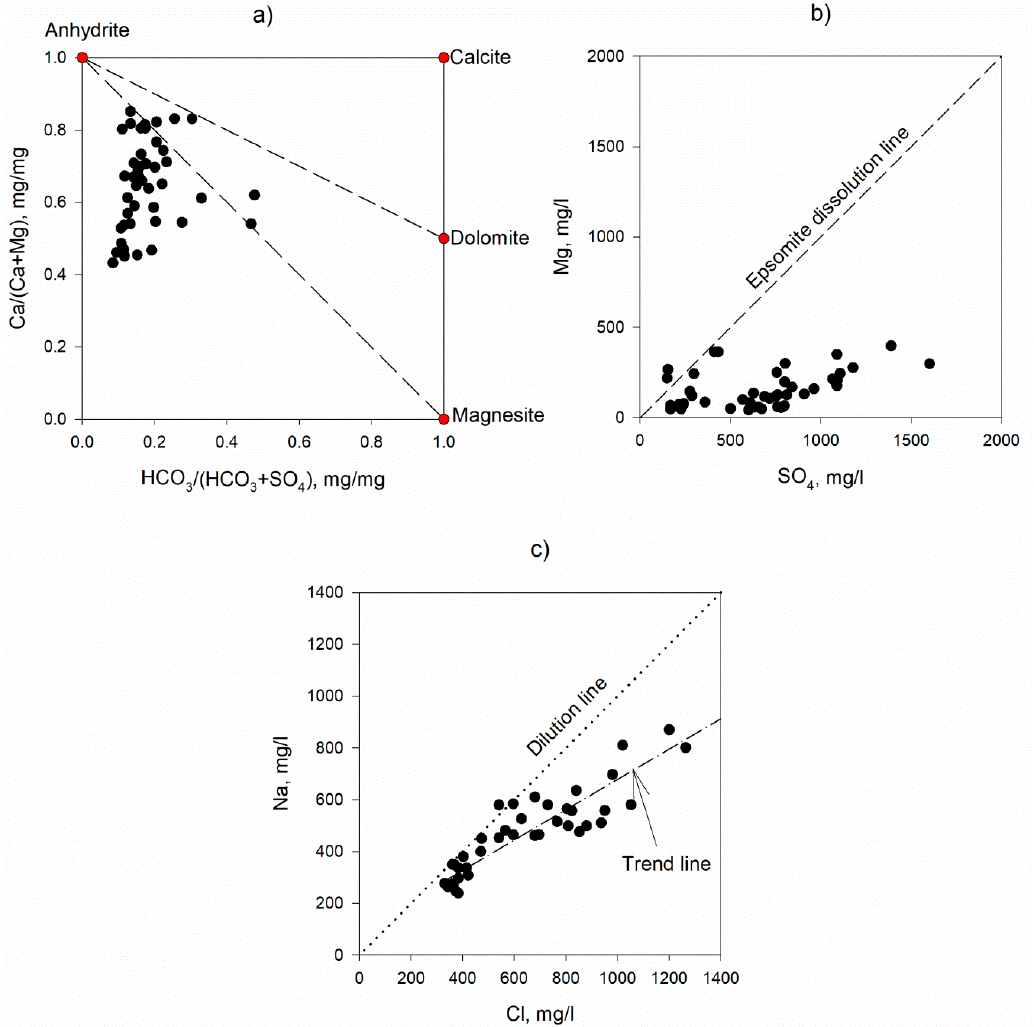
Figure 15. Binary diagrams: ( a ) Ca/(Ca + Mg) vs. HCO 3 /(HCO 3 + SO 4 ), ( b ) Mg vs. SO 4 , and ( c ) Figure 15. Binarydiagrams: ( a )Ca / (Ca + Mg)vs. HCO 3 / (HCO 3 + SO 4 ), ( b )Mgvs. SO 4 , and( c )Correlation Correlation diagrams of Na vs. Cl, for the water samples from the Shatt Al-Arab River. diagrams of Na vs. Cl, for the water samples from the Shatt Al-Arab